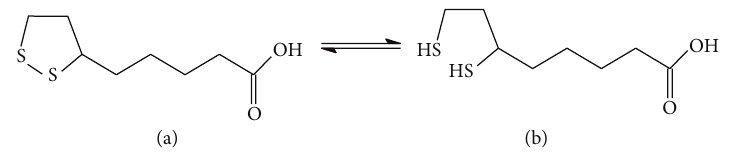
Figure 1: Lipoic acid (LA) (a) and its reduced form dihydrolipoic acid (DHLA) (b).